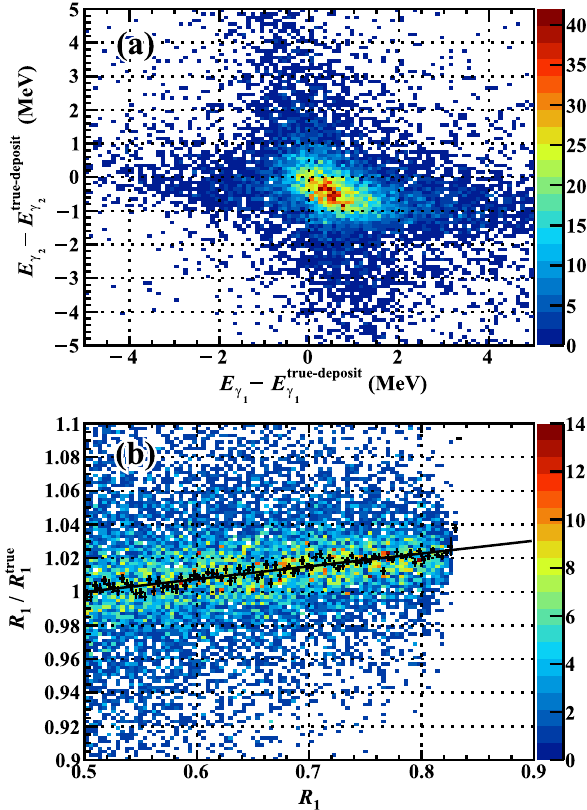
Fig. 10 a Scatter plot of the energy reconstruction errors (MC). − deposit E true γ 1 ( 2 ) is the MC true value of the energy deposited in the LXe. b Dependence of the reconstructed energy ratio bias as a function of the reconstructed energy ratio